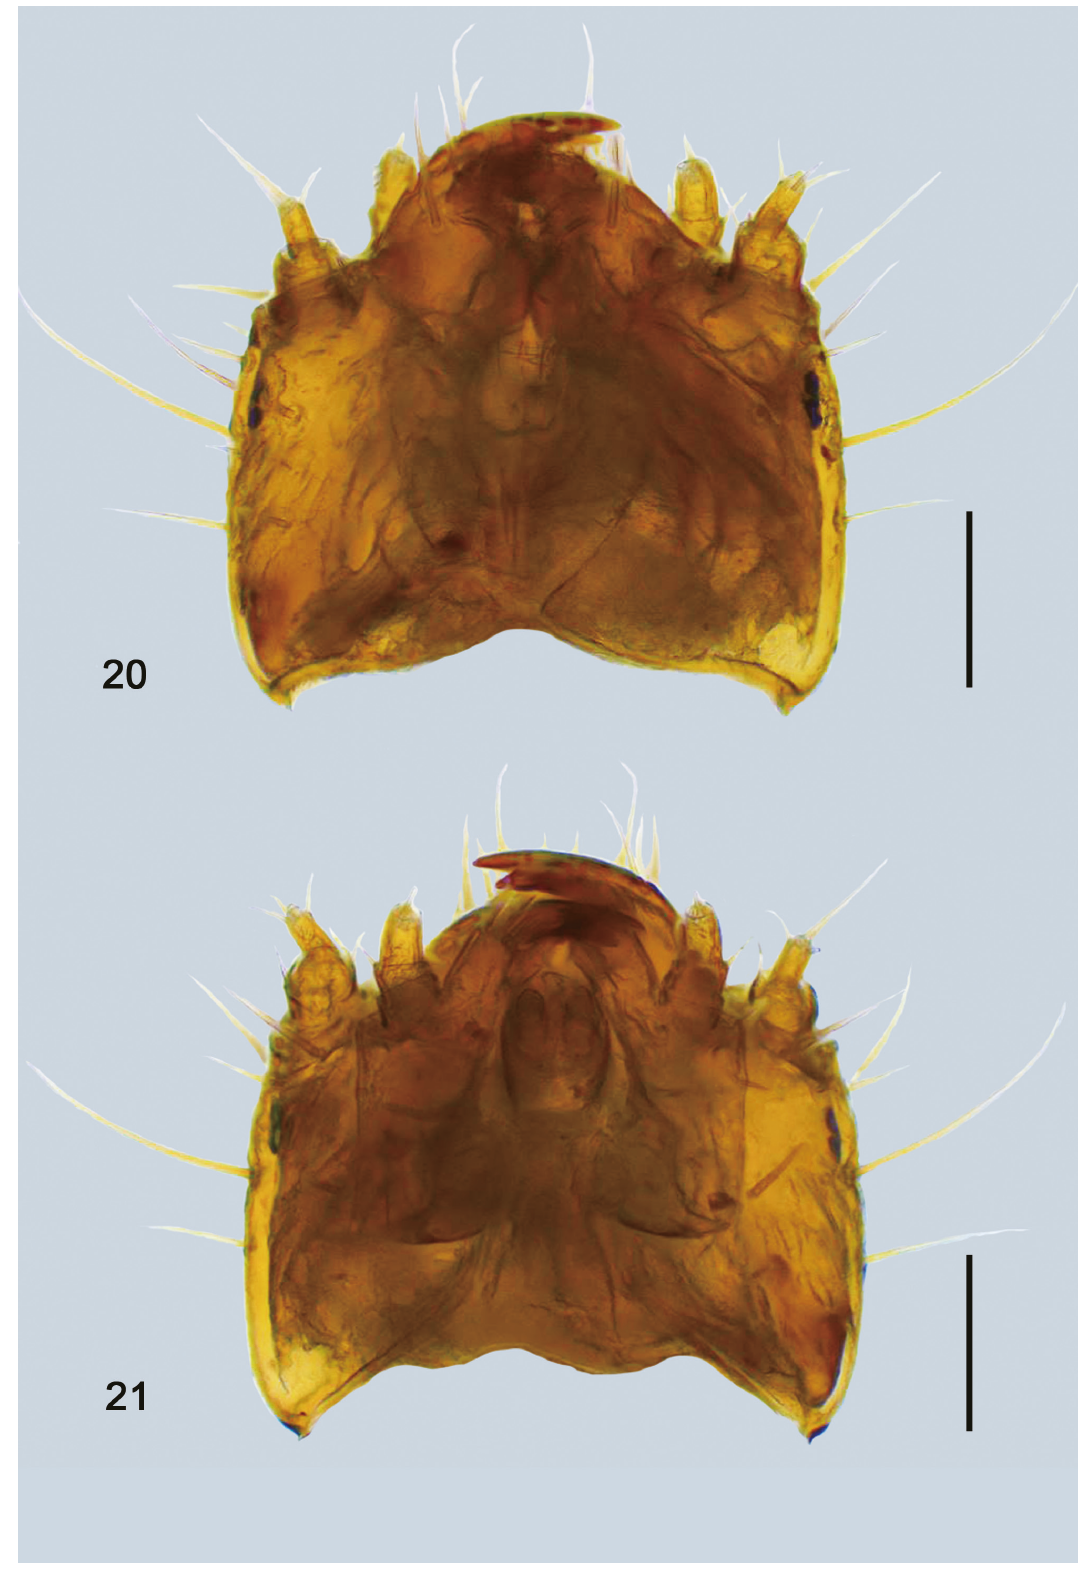
Figs 20–21. Head of first-instar larva of Trictenotoma formosana Kriesche, 1919. 20 . Dorsal view. 21 . Ventral view. Scale bars: 0.1